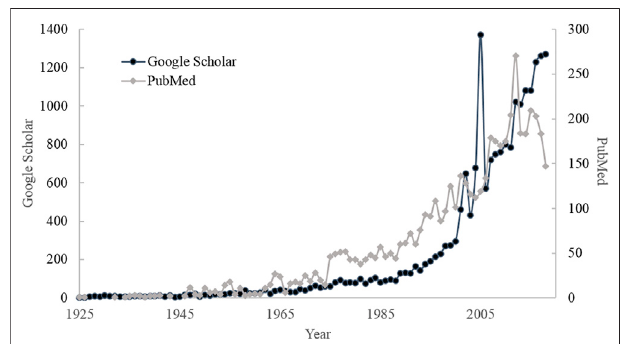
FIGURE 1 | The number of publications searched by Google Scholar and PubMed with the keyword “ Skin sensitization.